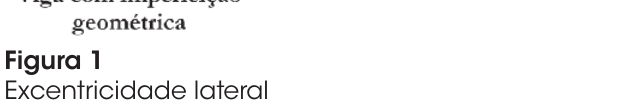
Excentricidade lateral